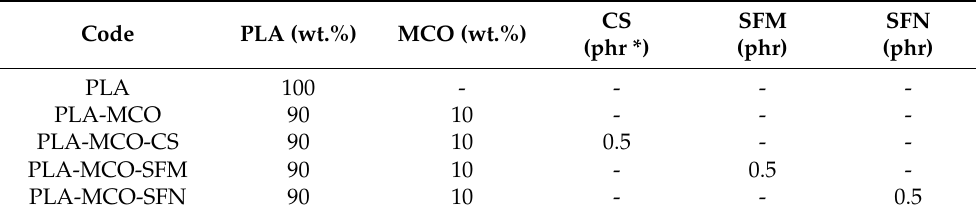
Table 1. Code and composition of samples PLA-Silk.